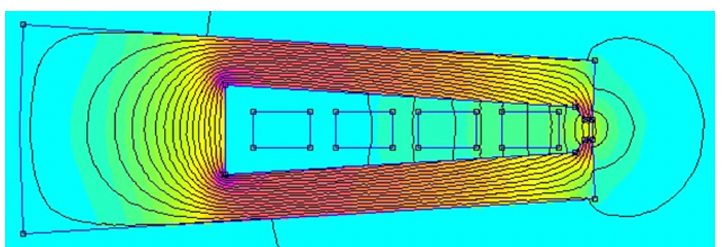
Figure 14. Trapezoidal slot with narrow teeth.